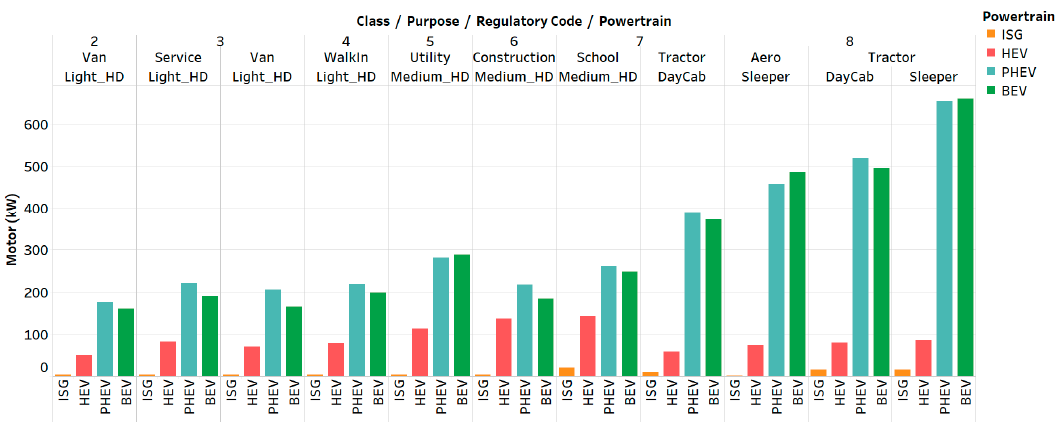
Figure 4. Peak motor power required for various truck variants.